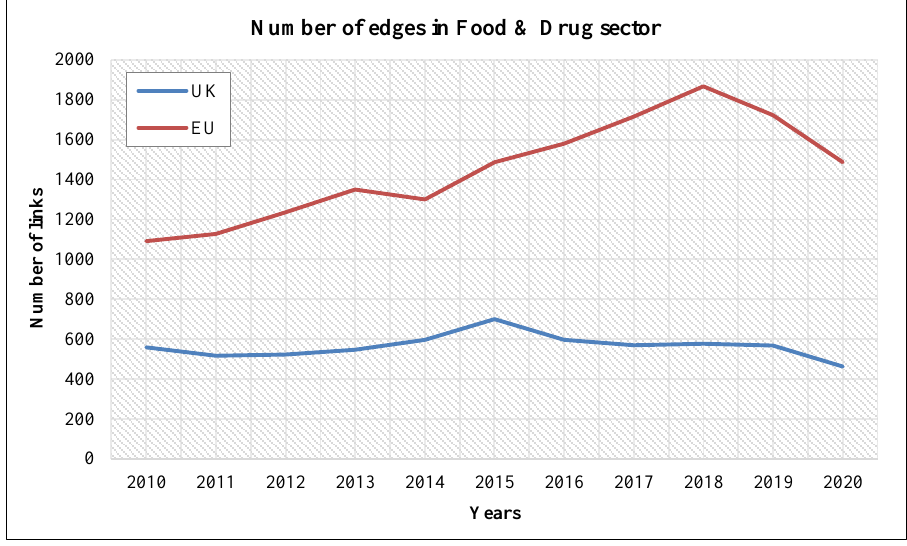
Figure 9. Comparison Analysis for the Number of Edges in Food & Drug